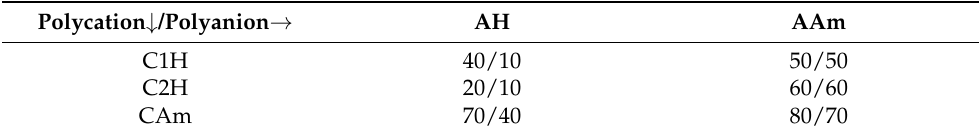
Table 2. The approximate values of water contact angles [ ◦ ] for all PEMs studied. The values of contact angles for cationic (left) and anionic (right) topmost layers are given for PEMs composed of at least 5 and 6 layers,